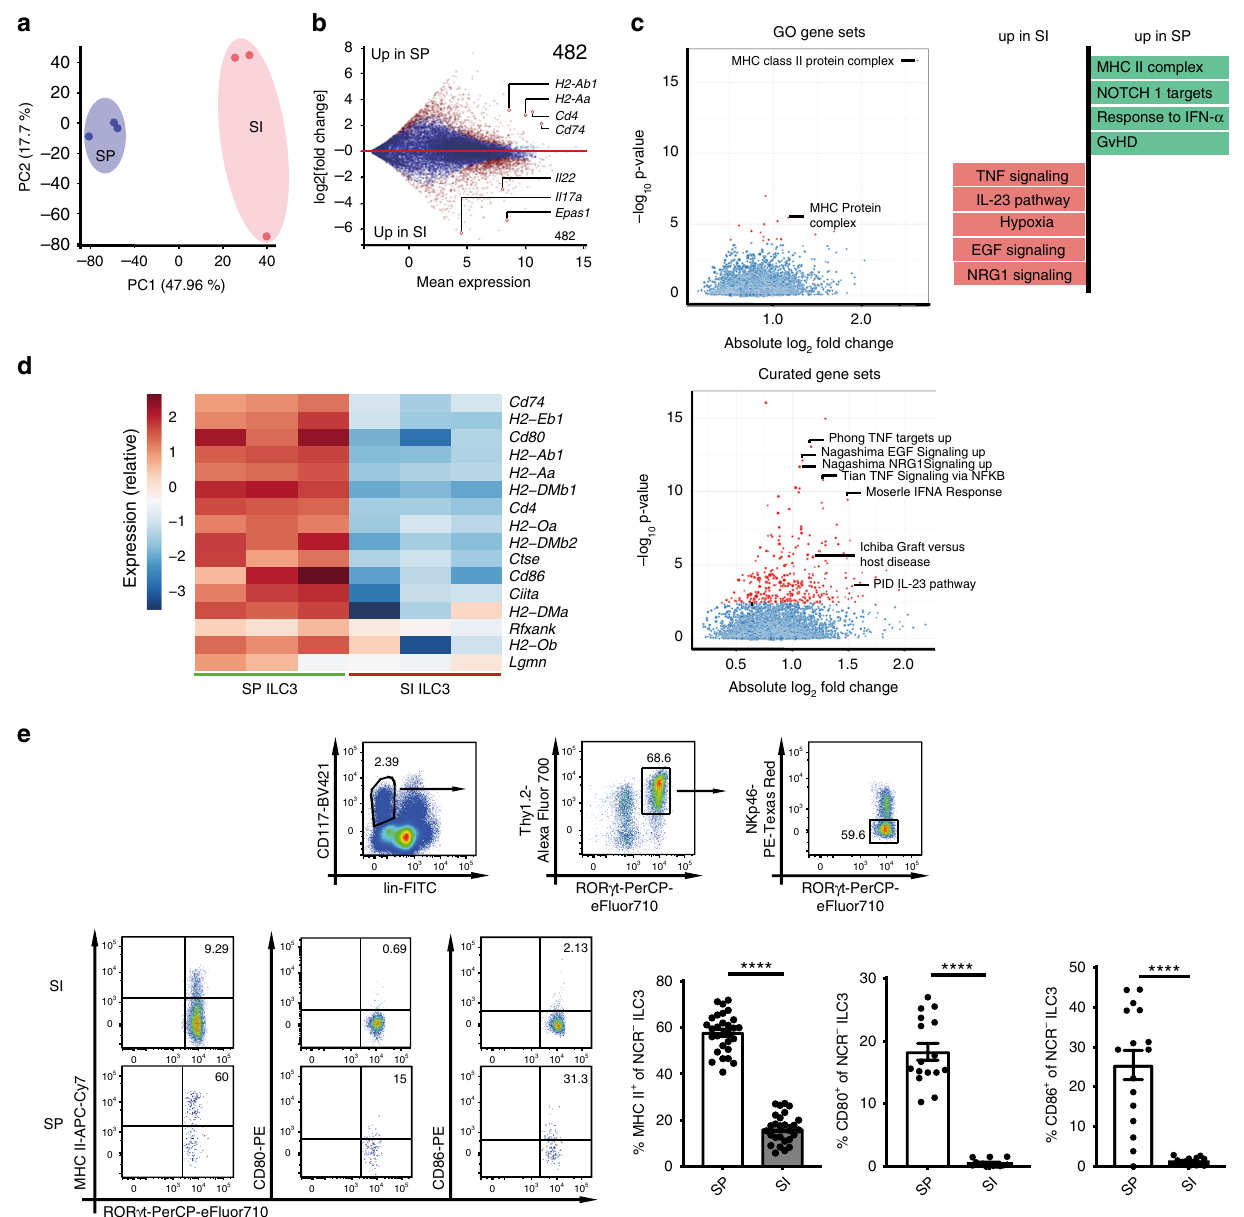
Fig. 1 SP and SI NCR − ILC3s exhibit a different transcriptional signature. a PCA of RNA sequencing data of SI and SP NCR − ILC3s isolated from Ror γ t fm + mice. Cells were sort-puri fi ed as depicted in Supplementary Fig. 1a. b Mean expression and log 2(fold change) of all detected genes. Genes with a signi fi cant difference are highlighted in red (FDR < 0.05). Numbers indicate the total amount of genes signi fi cantly higher expressed (log2(fold change) >1.5) in SP ILC3s or SI ILC3s. c Gene set enrichment analysis of gene ontology (GO) and curated gene sets. Gene sets with a signi fi cant difference are highlighted in red (FDR < 0.05). d Heatmap of genes associated with MHC II Ag presentation. e CD117 + lin − Thy1.2 + ROR γ t + NKp46 − ILC3s were analyzed for surface expression of MHC II ( n = 29(SP) and n = 27(SI) mice), CD80 ( n = 16(SP) and n = 14(SI) mice), and CD86 ( n = 16(SP) and n = 14(SI) mice). Six to eight independent experiments. Each symbol represents a sample and the bar graph represents the mean ± s.e.m. **** P ≤ 0.0001, calculated with unpaired two-tailed Student ’ s t test. Source data are provided as a Source Data